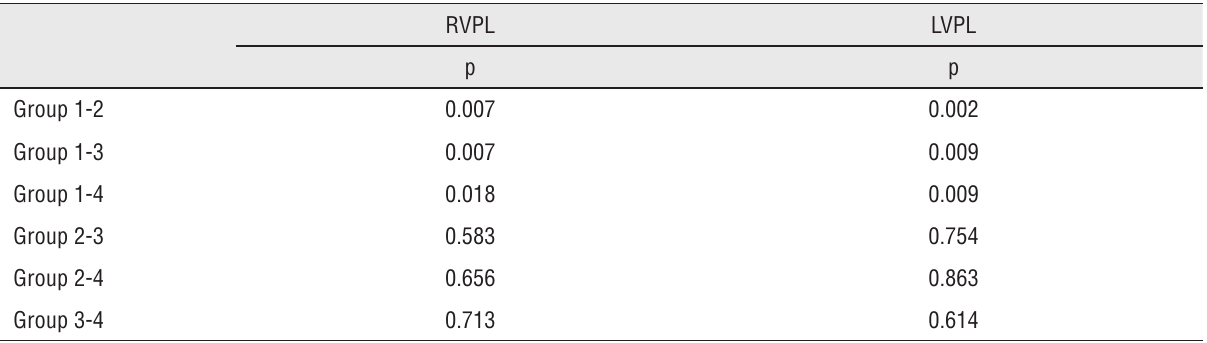
Table 2 - Epv comparative analyses of Group 1 at the 47 th day and Groups 2, 3, and 4 at the 40 th day.